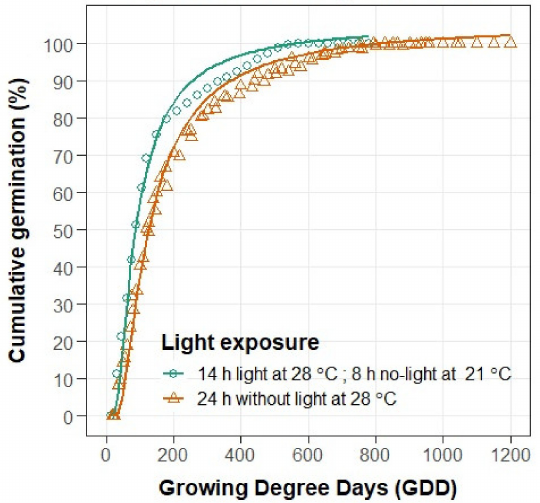
Figure 2. Light effects on cumulative seed germination in 26 C. campestris populations depending on growing degree days